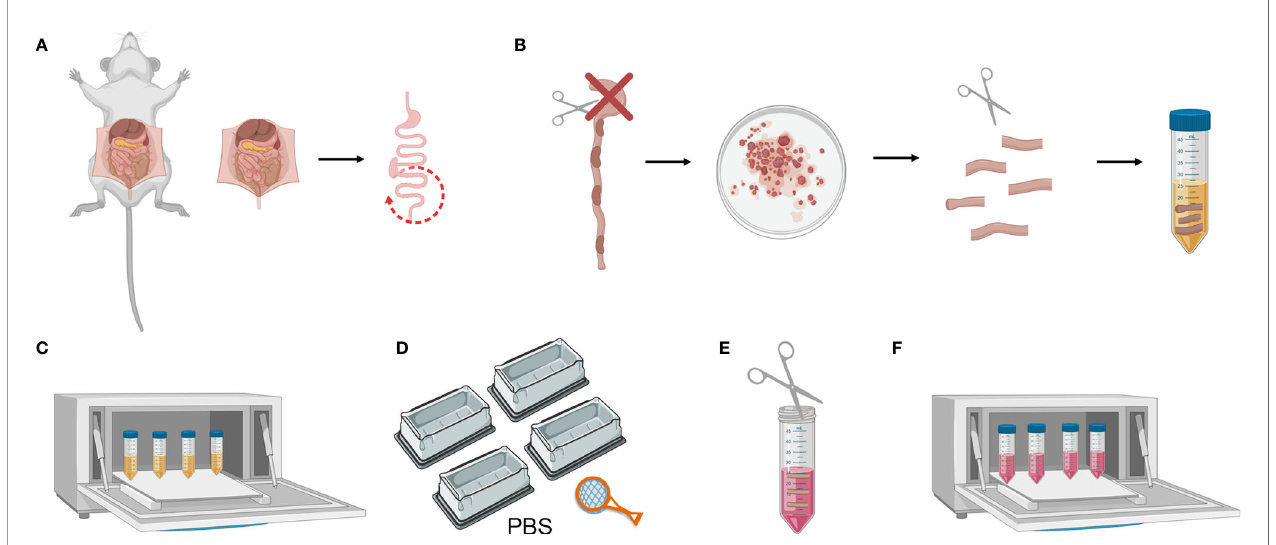
FIGURE 2 | Mouse colon tissue processing. (A) Colon harvesting from mouse. (B) Washing the colon and cutting longitudinally and transversally. (C) Predigestion of tissue pieces at 37 ° C by shaking. (D) Thorough cleaning of the tissue pieces with PBS 1X. (E) Mincing pieces of colon with scissors (F) Enzymatic digestion of tissue pieces at 37 ° C by